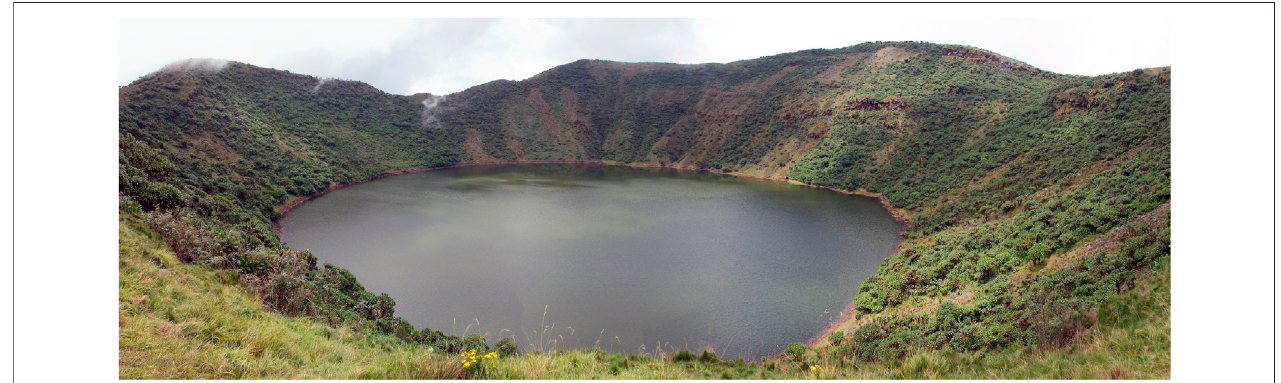
FIGURE 6 | Crater lake of Mt Bisoke (Rwanda) (November 2013; picture by